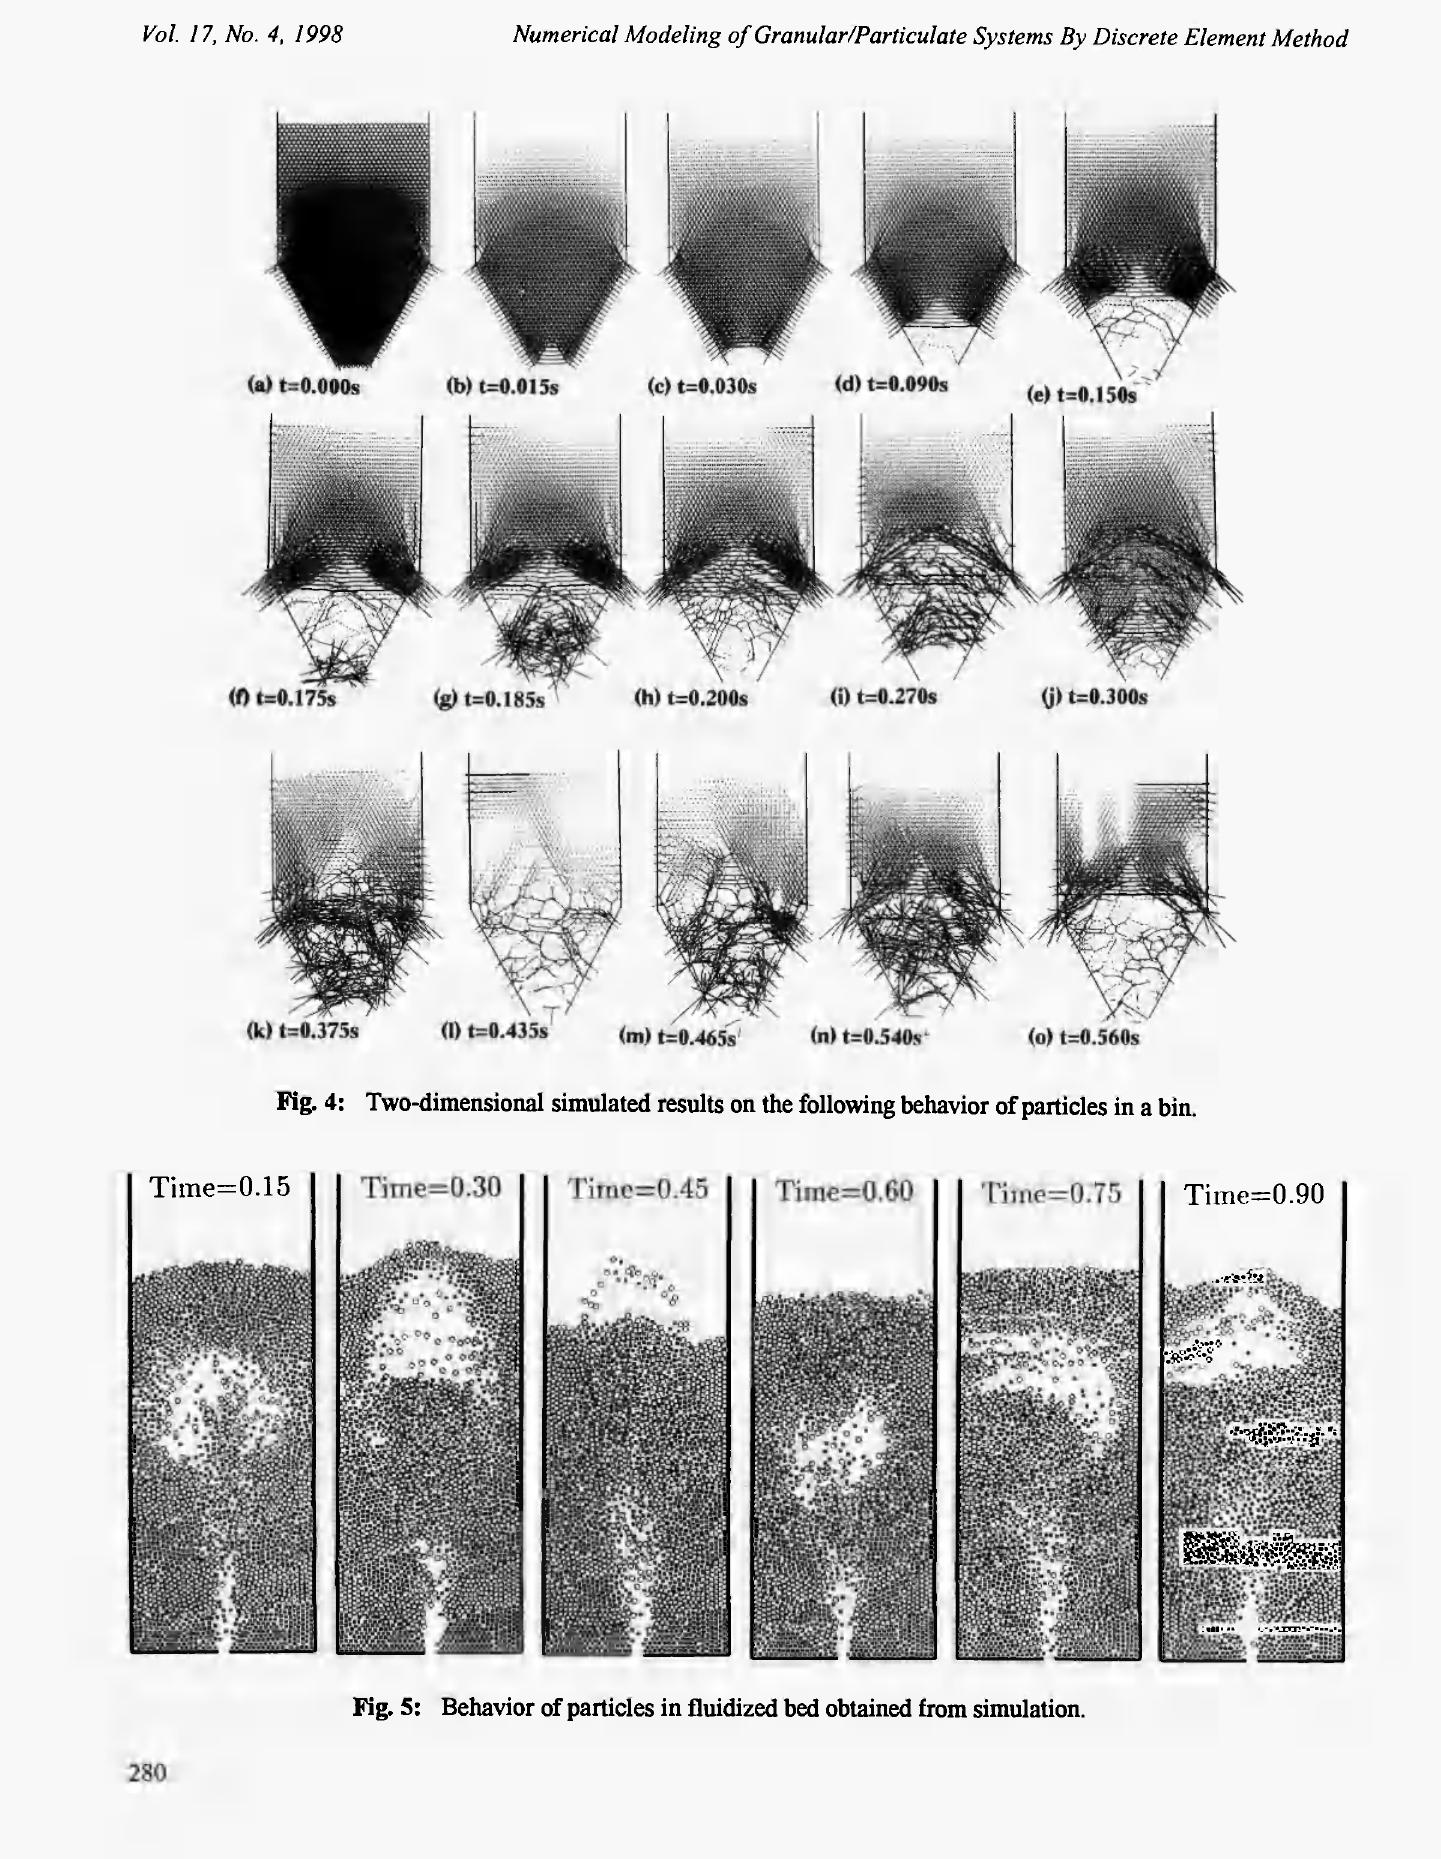
Fig. 5: Behavior of particles in fluidized bed obtained from